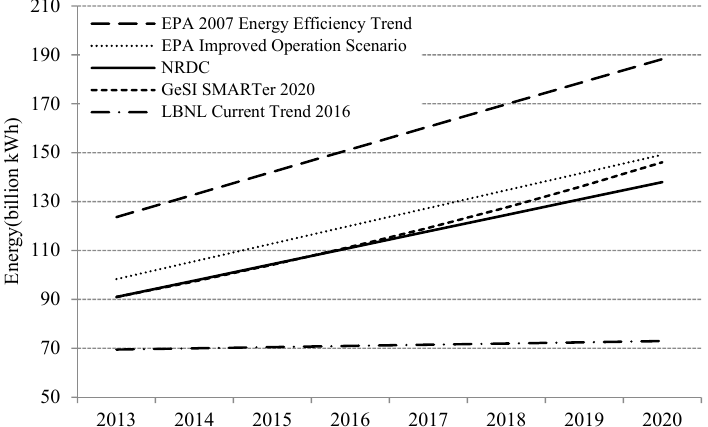
Figure 1. Prediction on electricity consumption of data centers in U.S. Data extrapolated on [1,3–5]. GeSI SMARTer 2020 data is extrapolated by 7% annual increase rate of Global data centers emission (GtCO2e) with the baseline of NRDC 2011 data.